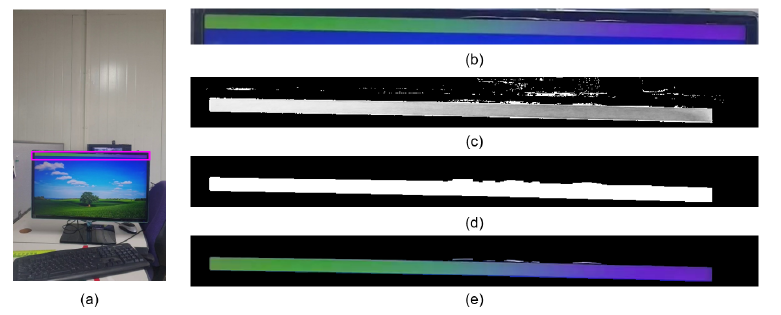
Figure 5. The extraction process of a color barcode area: ( a ) the YOLO result; ( b ) YOLO-based ex- traction of the color barcode area; ( c ) a color barcode mask using differential images; ( d ) the color barcode mask using a morphology operation; and ( e ) a color barcode with noise removal.